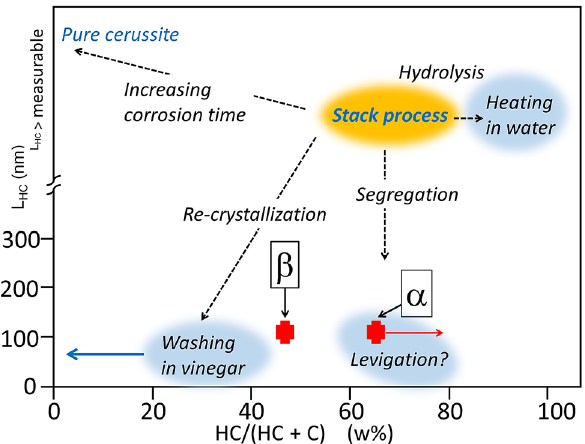
Figure 4. Diagram showing the thickness L HC of HC platelets as a function of lead white composition HC/ (HC + C). The colored areas with diffuse contours represent the locations of experimental values measured for 24 samples taken from Renaissance paintings (14). Broad red crosses represent the values measured for fragments α and β in the St. Anne sample. The red arrow indicates the fact that the HC content of the α fragment is likely to be slightly